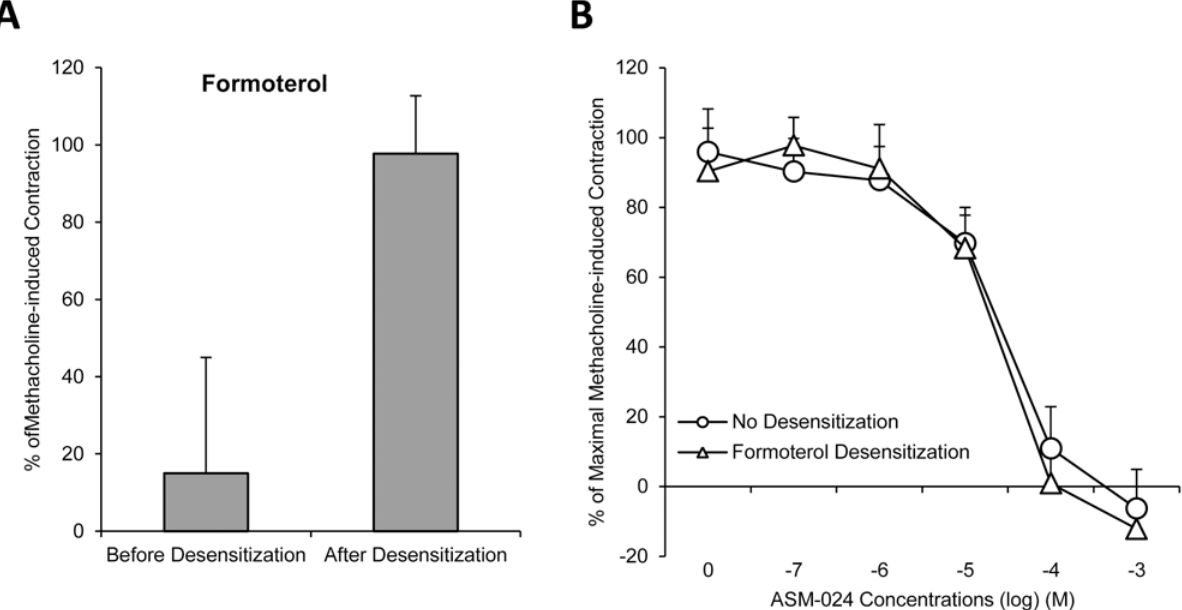
Fig 4. Relaxant Effects of ASM-024, on Salmeterol Desensitized Guinea-Pig Tracheas. A) Intact guinea pig tracheas were studied before and after 18 h of exposure to the long acting β 2 agonist formoterol. A reduced relaxation response to salbutamol is observed after 18 hour exposure to formoterol (p < 0.05). B) No significant difference was observed on the relaxation response curves of ASM-024 on intact or salmeterol desensitized tracheas. n = 4.